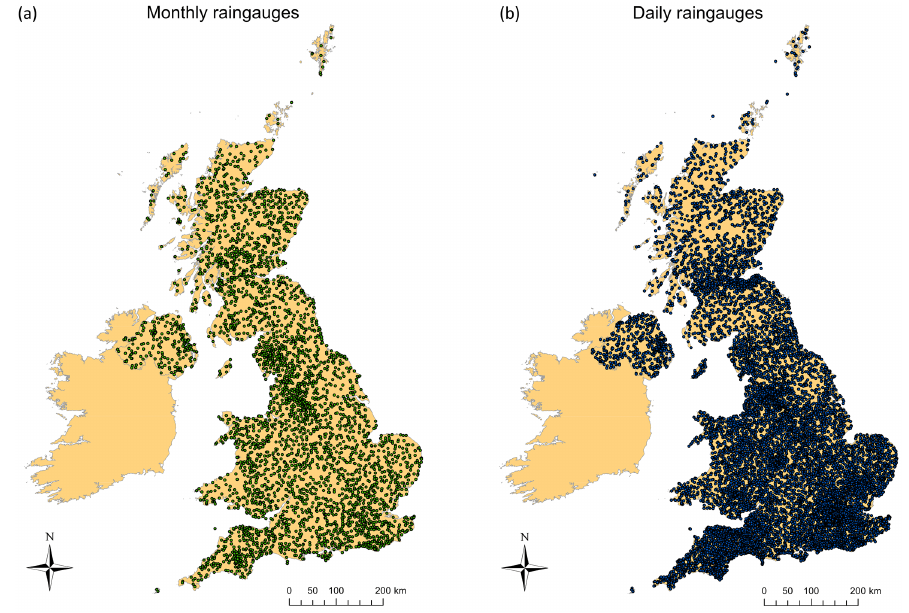
Figure 1. Maps of daily rain gauges used to derive the CEH-GEAR data set: (a) monthly rain gauges and (b) daily rain